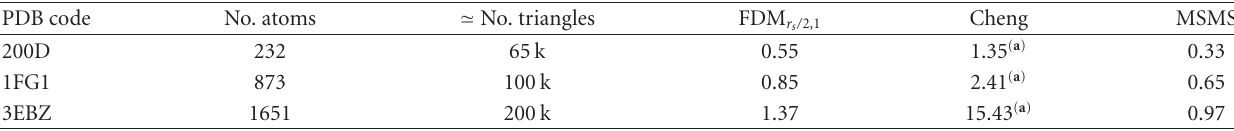
Table 2: Computation times (in s) for di ff erent methods. ( ( a ) from [30].)